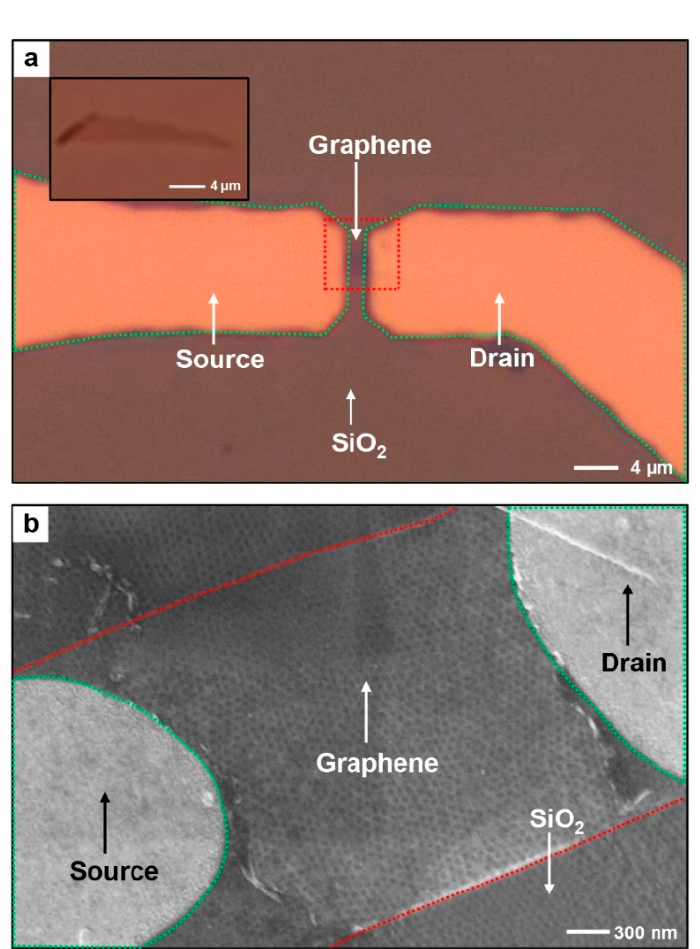
Figure 3. A top view ( a ) OM and ( b ) SEM image of partially suspended G-FETs on AES. Average pore diameter of AES is 31 nm and monolayer graphene is used for the G-FETs fabrication.